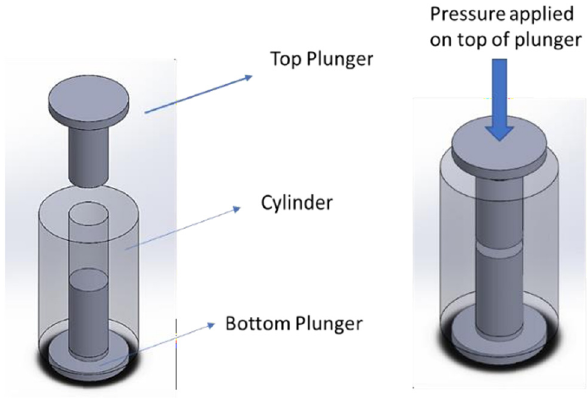
Figure 1: Powder compaction